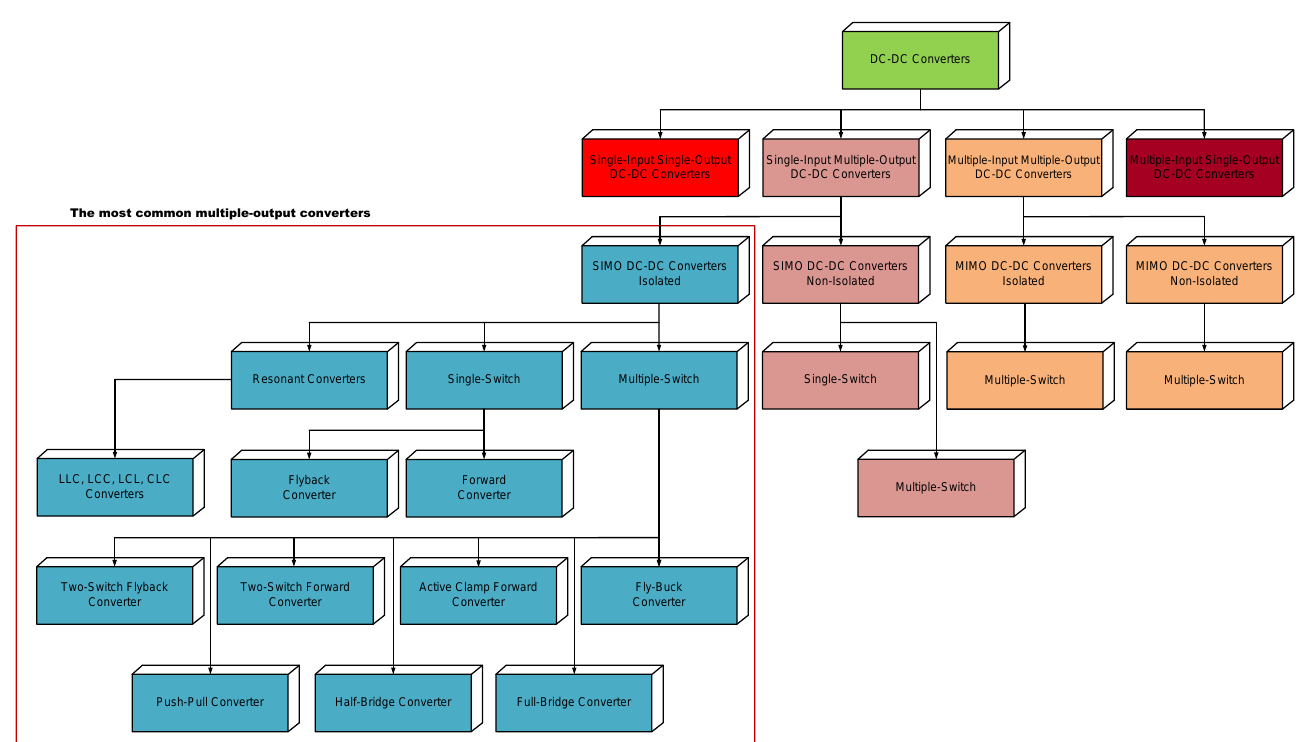
Figure 1. Multiple-Output DC – DC Converters Classification.